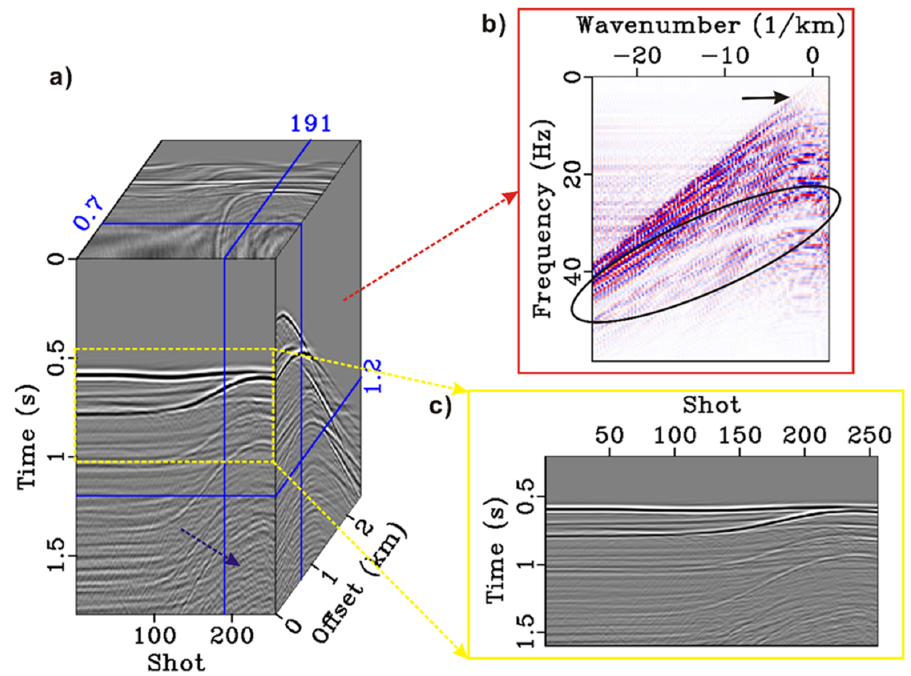
Figure 7. The conventional deghosting results. ( a ) 3D data cube including 256 CSGs and 256 COGs. ( b ) f - k spectrum in which the black oval marks the effect of ghost. ( c ) COG wherein the events are similar to the underground interface.